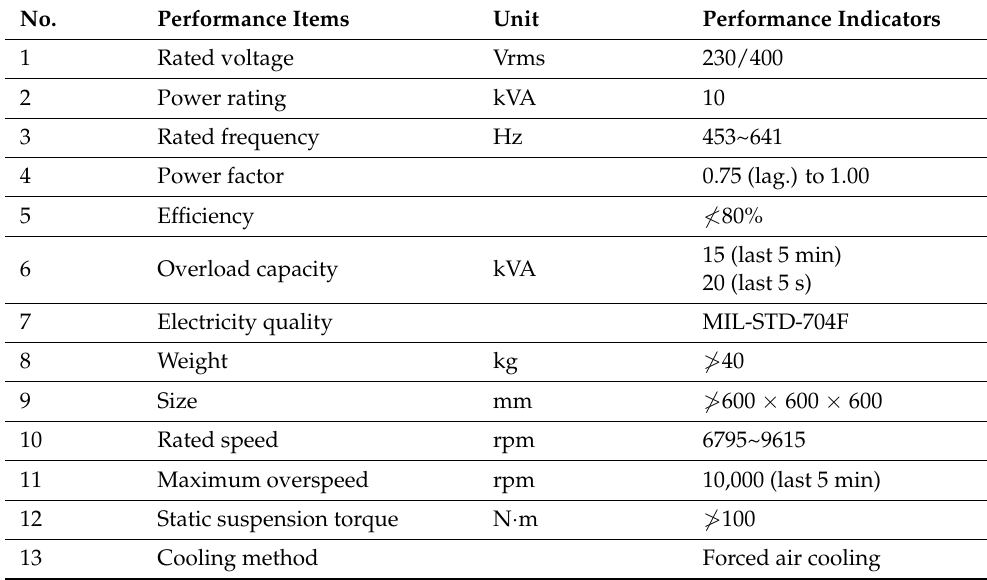
Table 3. Generator performance